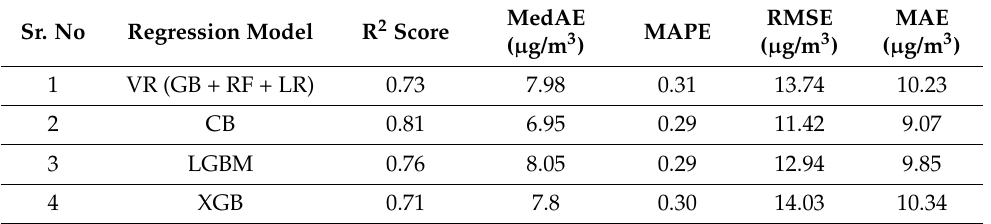
Table 8. PM 2.5 concentration prediction performance analysis using various regression